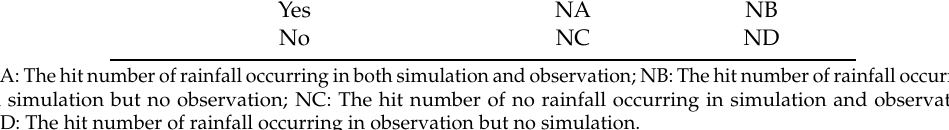
Table 5. Rain / no rain contingency table for the simulation against the observation. Simulation / Observation Yes No Yes NA NB No NC